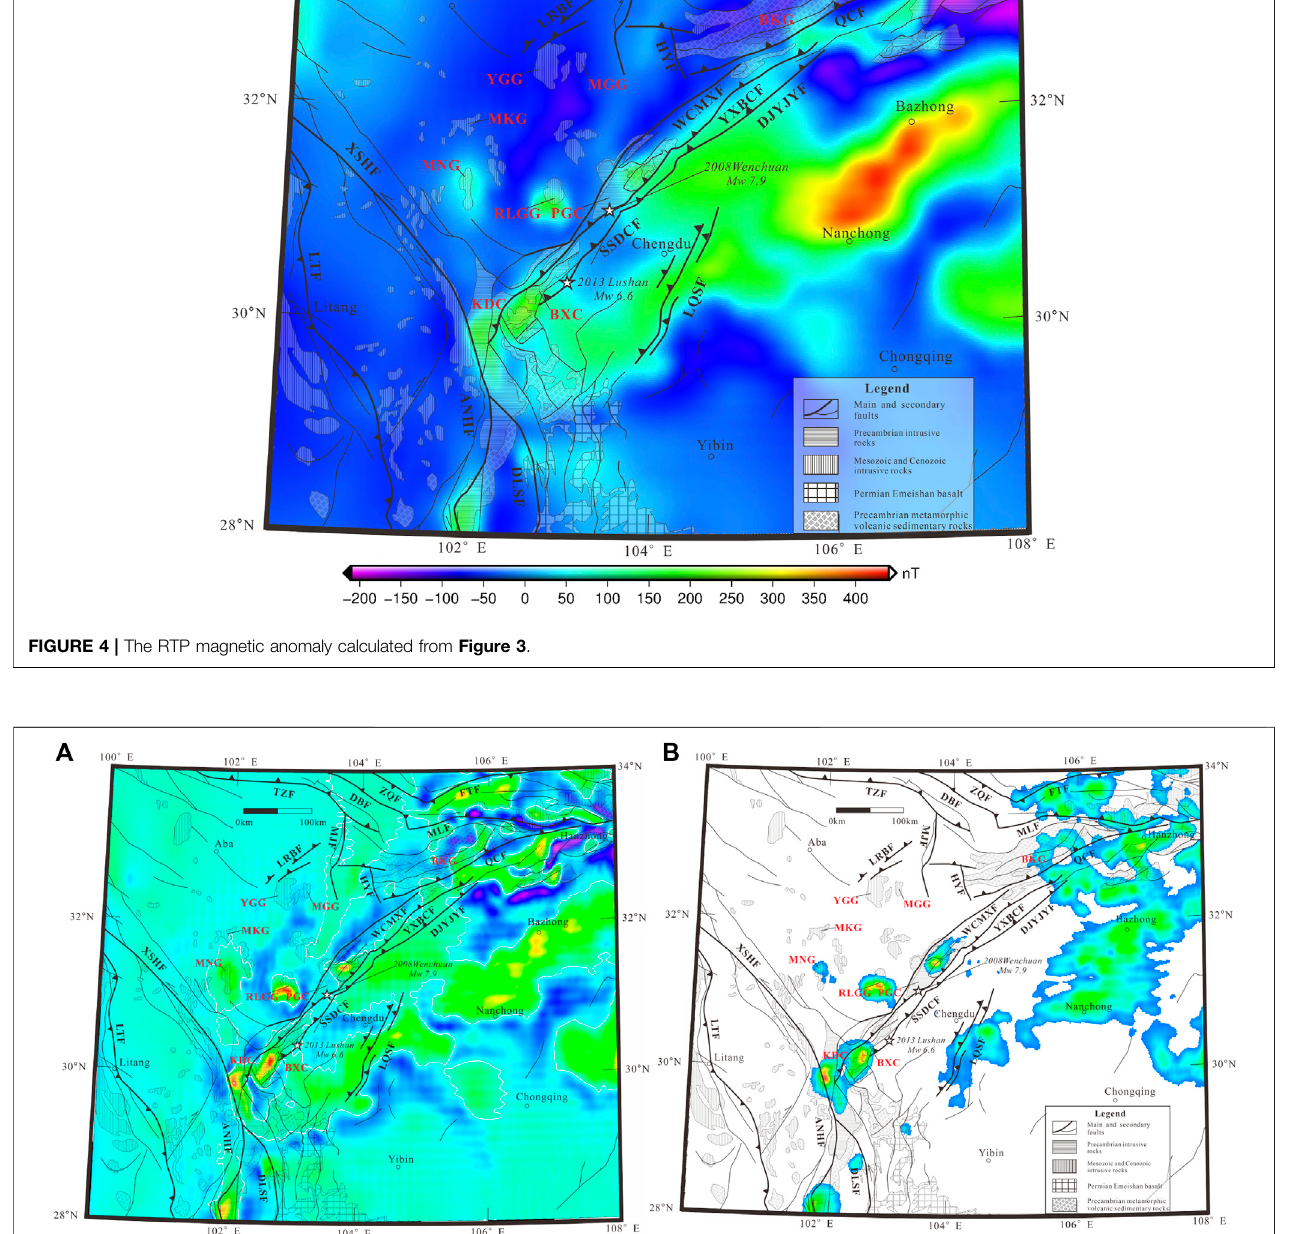
Frontiers in Earth Science |